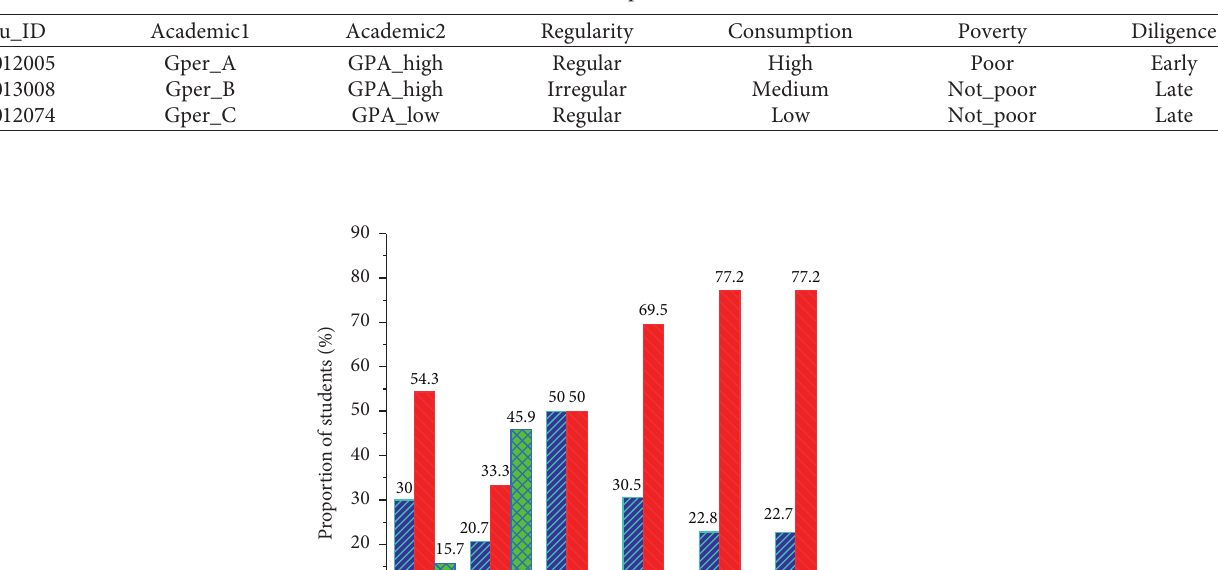
Table 9: Format of the processed dataset.